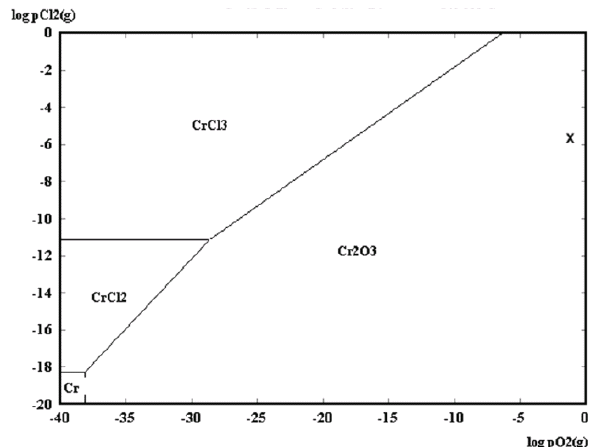
Figure 3. Cr-O-Cl phase stability diagram at 833 K. Equi- librium composition of experiment 1 is marked with X.